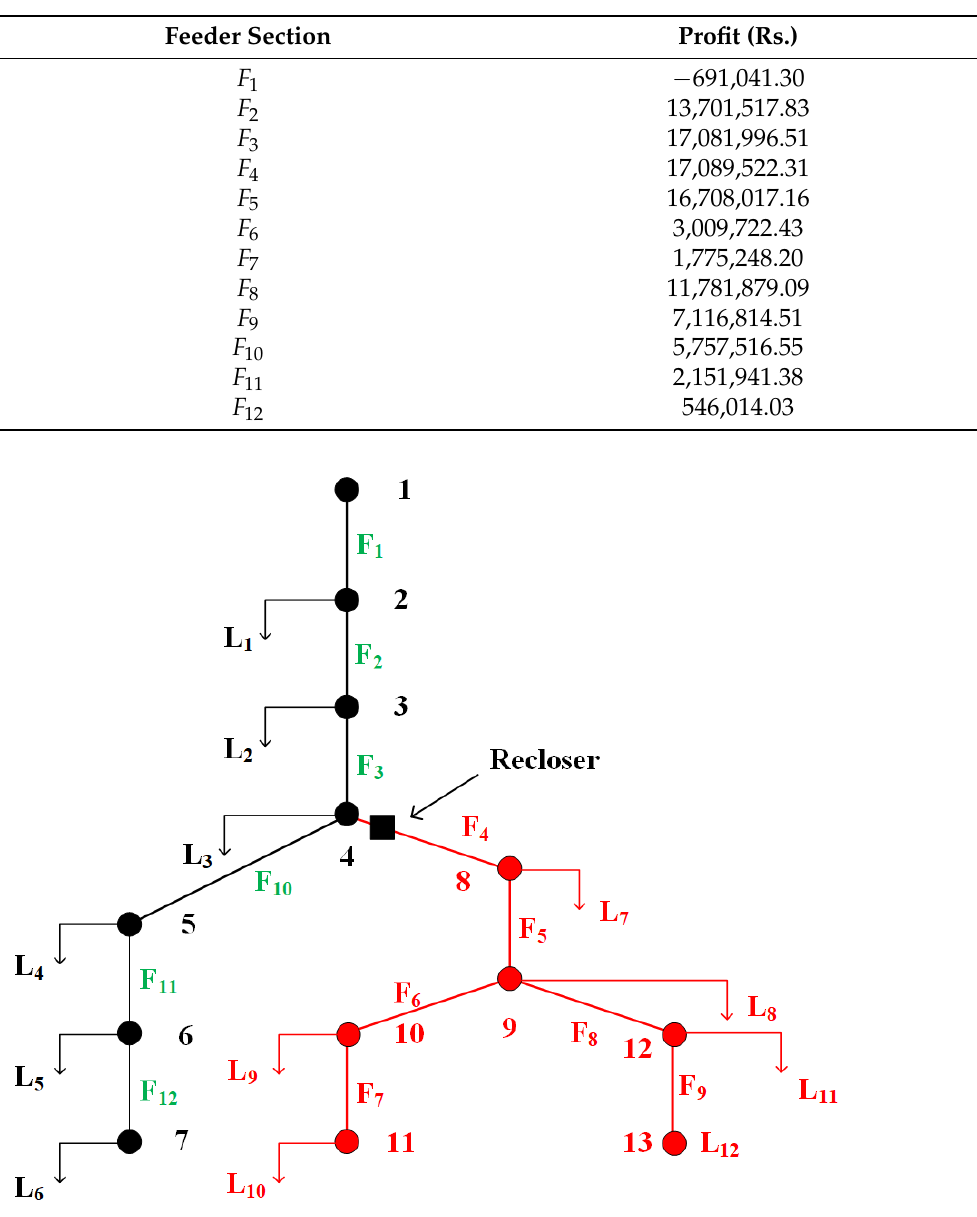
Figure 4. A recloser placed in feeder section F 4 of the 13-bus